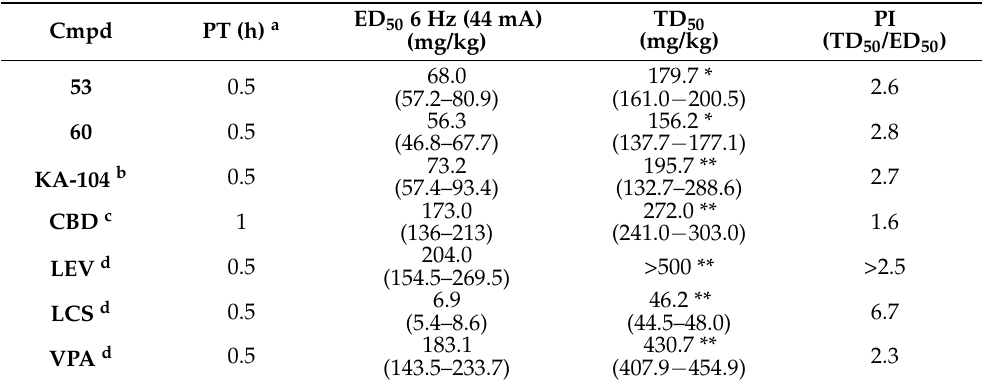
Table 3. Effect of the synthesized compounds and reference ASDs that were administered i.p. in the 6 Hz (44 mA) seizures in